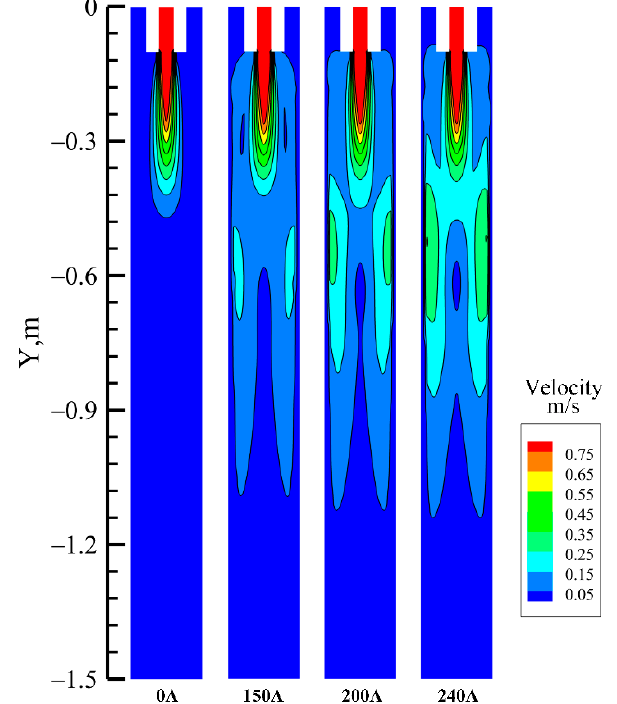
Figure 6. The velocity contour on the plane of Z = 0.